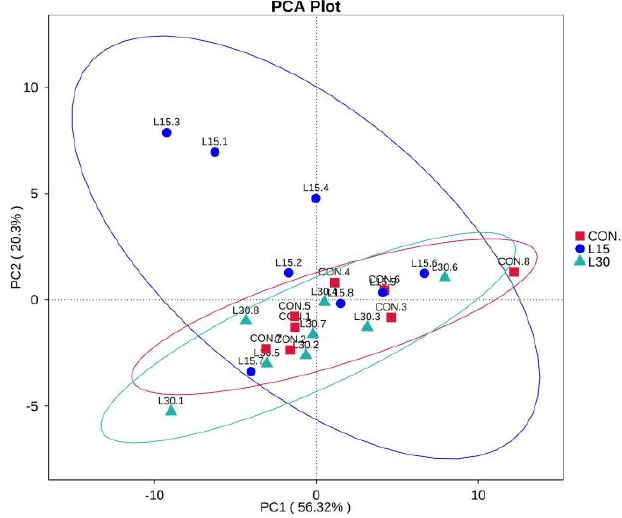
Figure 5. PCA of level 2 functional analysis of fecal microorganisms via Tax4fun. CON, 0% FHTRin the diet; L15, 15% FHTR in the diet; L30, 30% FHTR in the diet.